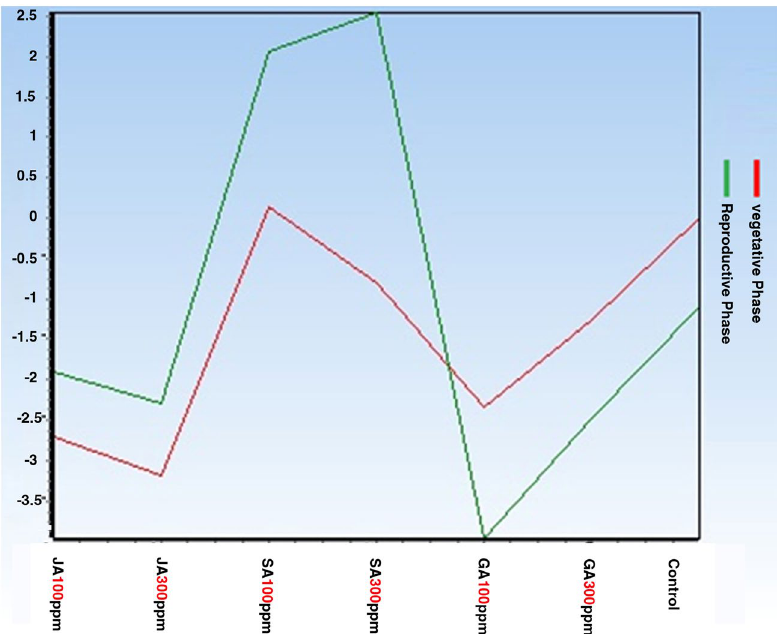
Figure 2. Changes in C4H gene expression in the aerial part under different hormonal treatments at different phenological stages.